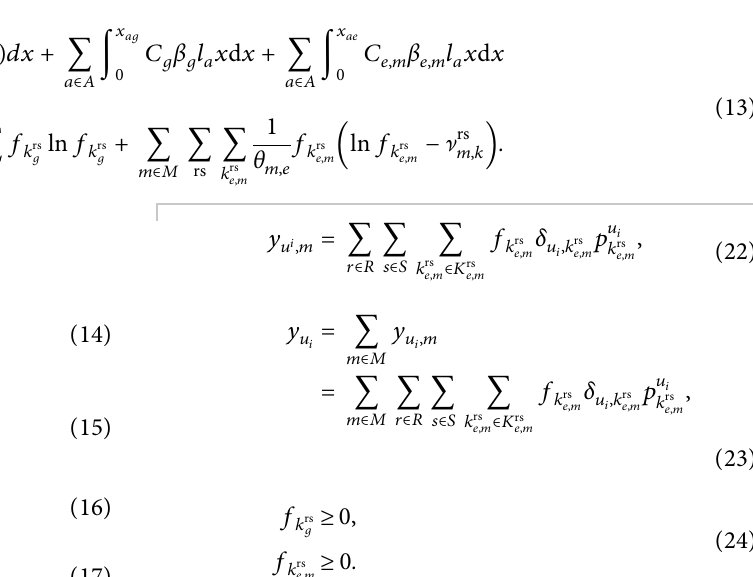
Equation (13) is the minimization objective function, which has no intuitive economic signifcance. Equations (14) and (15) are the relationship between path fow and OD demand; equations (16) and (17) indicate the path trafc logit probability loading. Equation (18) represents the proportion of category m BEV in the total fow of BEV. Equations (19) and (20) are the relationship between the link fow and path fow of GV and BEV users, respectively; equation (21) is the relationship between the total link trafc and the link trafc of users in group m + 1; equations (22) and (23) represent the total possible charging fow of BEV at CS u i . Equation (24) is the non-negative constraint of path